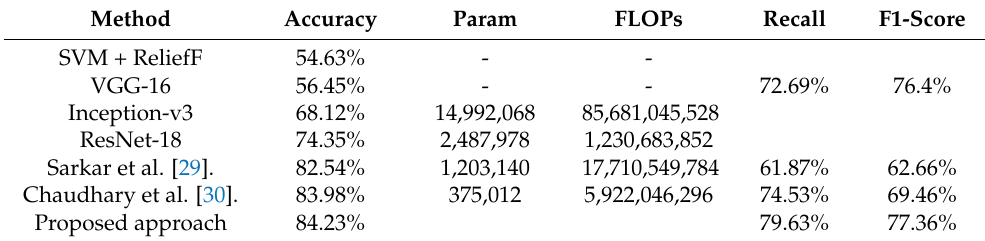
Table 3. Comparison of